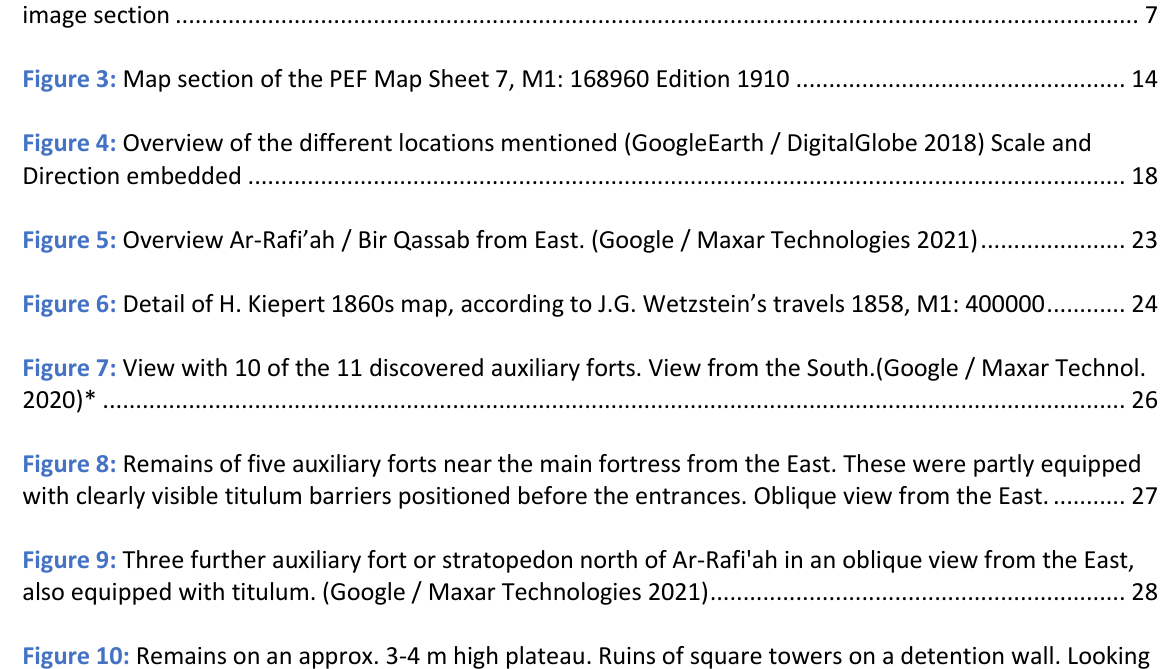
Figure 11: Detail of Fig.10 on a 2016 Image, contrast edited. Looking from the South. (Google / Maxar